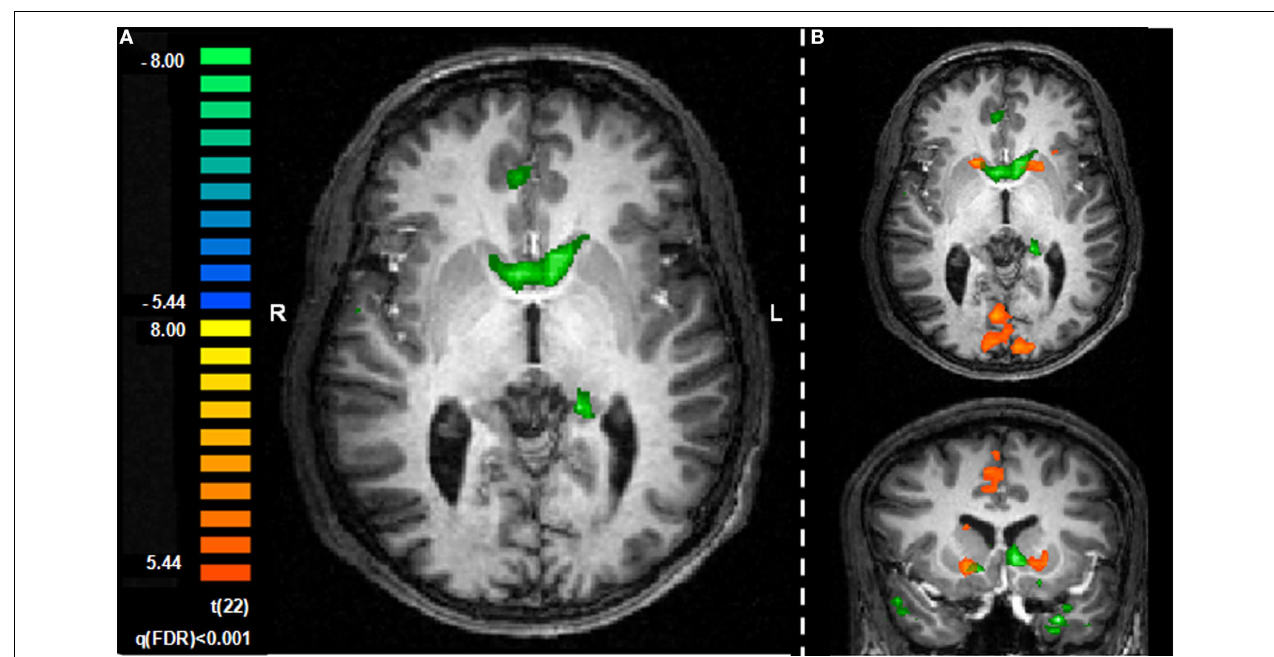
FIGURE 5 | Exploratory connectivity analysis with amygdala as a seed ROI. (A) Time course for the amygdala ROI extracted for each individual participant and entered as a single predictor in a general linear model correlates with activation in the striatum. (B) Striatum ROIs defi ned by the seed analysis (green) overlap with striatum ROIs defi ned by general contrast of aversive and safe trials (orange). Slices are shown in the axial ( z = 1) and coronal ( y = 13)